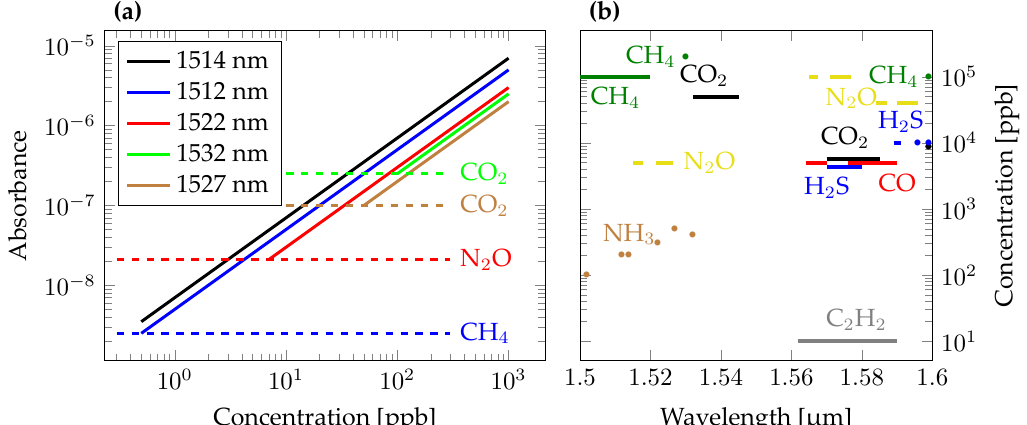
Figure 3. ( a ) Absorbance values for different concentrations of NH 3 in atmosphere for the investigated absorption lines and a propagation length of 1 m. The lower concentration limit is given by the absorption profiles of other gases in the atmosphere that overlap with the NH 3 lines. The limiting gases have been linked to the corresponding ammonia absorption lines with a dashed line. For this plot water vapour has been removed from the ambient air. ( b ) Detectable concentrations and wavelength ranges of different climate relevant gas species, assuming absorption signals of diagram represent a close set of multiple usable lines, whereas dots refer to single absorption